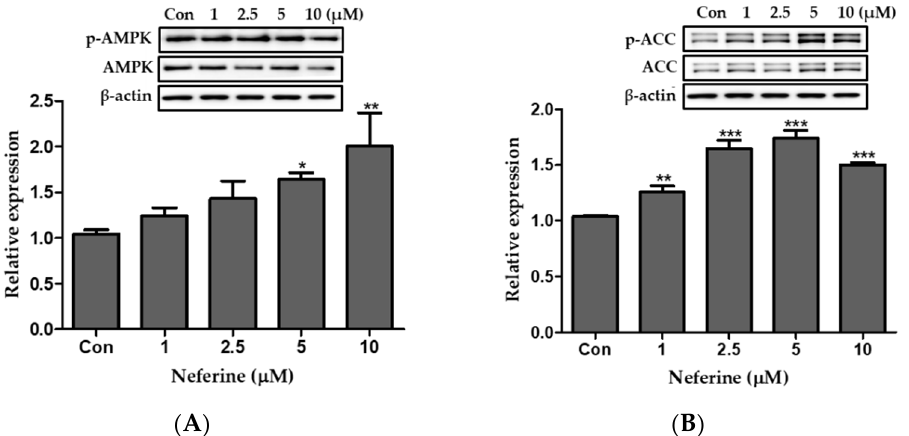
Figure 6. Effects of neferine on AMPK and ACC during the differentiation of 3T3-L1 adipocytes. Ratios of relative expression levels of ( A ) p -AMPK/AMPK and ( B ) p -ACC/ACC are presented. * p < 0.05, ** p < 0.01, and *** p < 0.001 vs. Con. All data are presented as mean ± SD, and experiments were performed at least thrice. The positive control (Con) was differentiated 3T3-L1 cells treated with adipocyte differentiation cocktail.